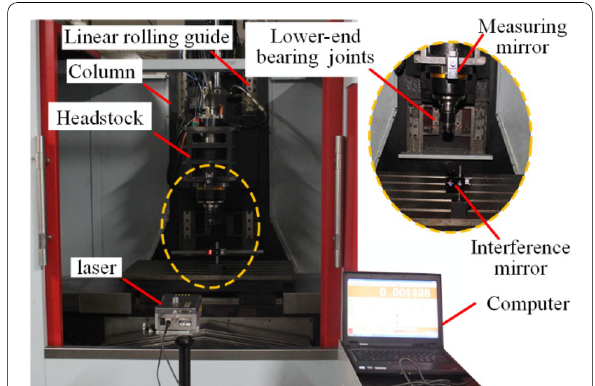
Figure 7 Experimental setup for characterizing the vibrations of the vertical feed system